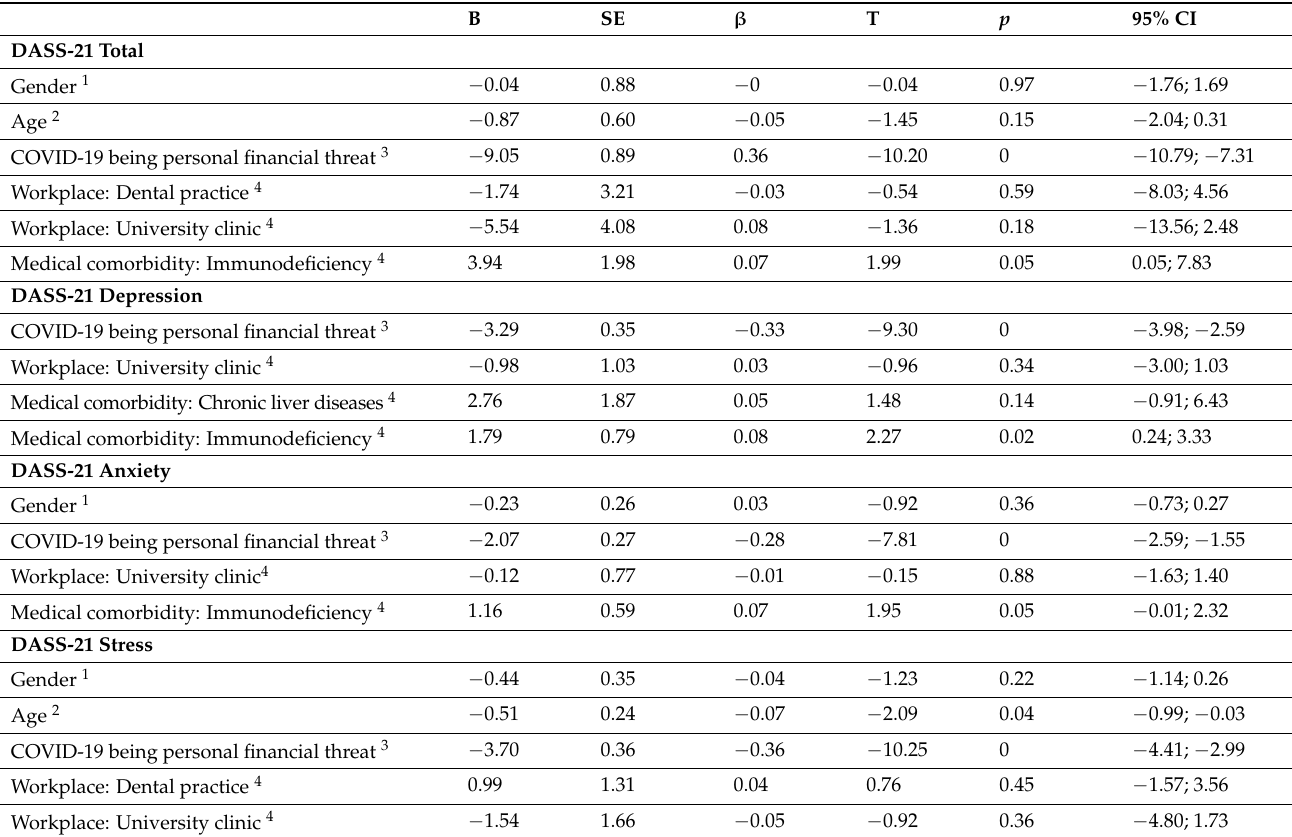
Table 6. Multiple regression analyses with relevant factors of DASS-21 total and subscores.